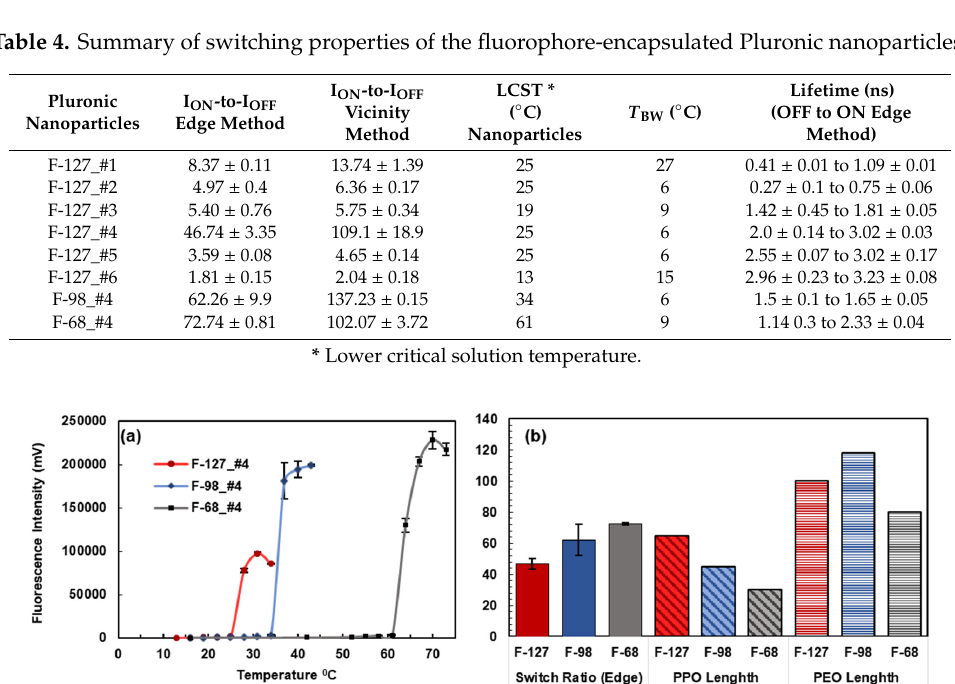
Figure 6. ( a ) Response of Pluronic F-127, F-98, and F-68 nanoparticles loaded with fluorophore 4 to the change in temperature. ( b ) Pluronic F-68 nanoparticles loaded with fluorophore 4 showed a stronger switching ratio compared to Pluronic F-127 nanoparticles ( p -value of 0.009). The switch ratio is inversely correlated to length of hydrophobic (PPO) chain ( ρ = − 0.99, p -value = 0.018). The observed significant polarity sensitivity of the fluorophores, considering their interconnected π -system, might be due to specific solvent-fluorophore interactions such as “charge transfer pathways,” which mainly include photo-induced electron transfer (PeT) and internal charge transfer (ICT).